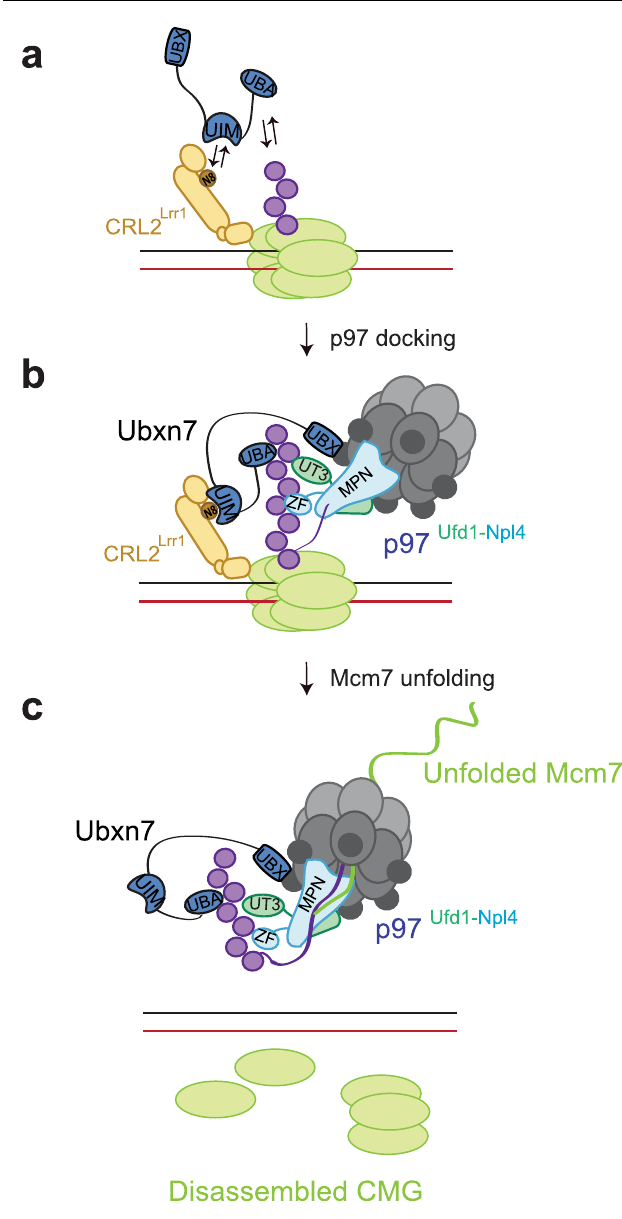
Fig. 6 | A model for p97 Ufd1-Npl4-Ubxn7 assembly on ubiquitylated CMG. a Ubxn7 binds weakly and transiently to ubiquitylated CMG-CRL2 Lrr1 prior to p97 Ufd1-Npl4 binding. b Multi-valent and cooperative interactions stabilize p97 Ufd1-Npl4-Ubxn7 bind- ing to ubiquitylated CMG-CRL2 Lrr1 , allowing initiation of ubiquitin chain